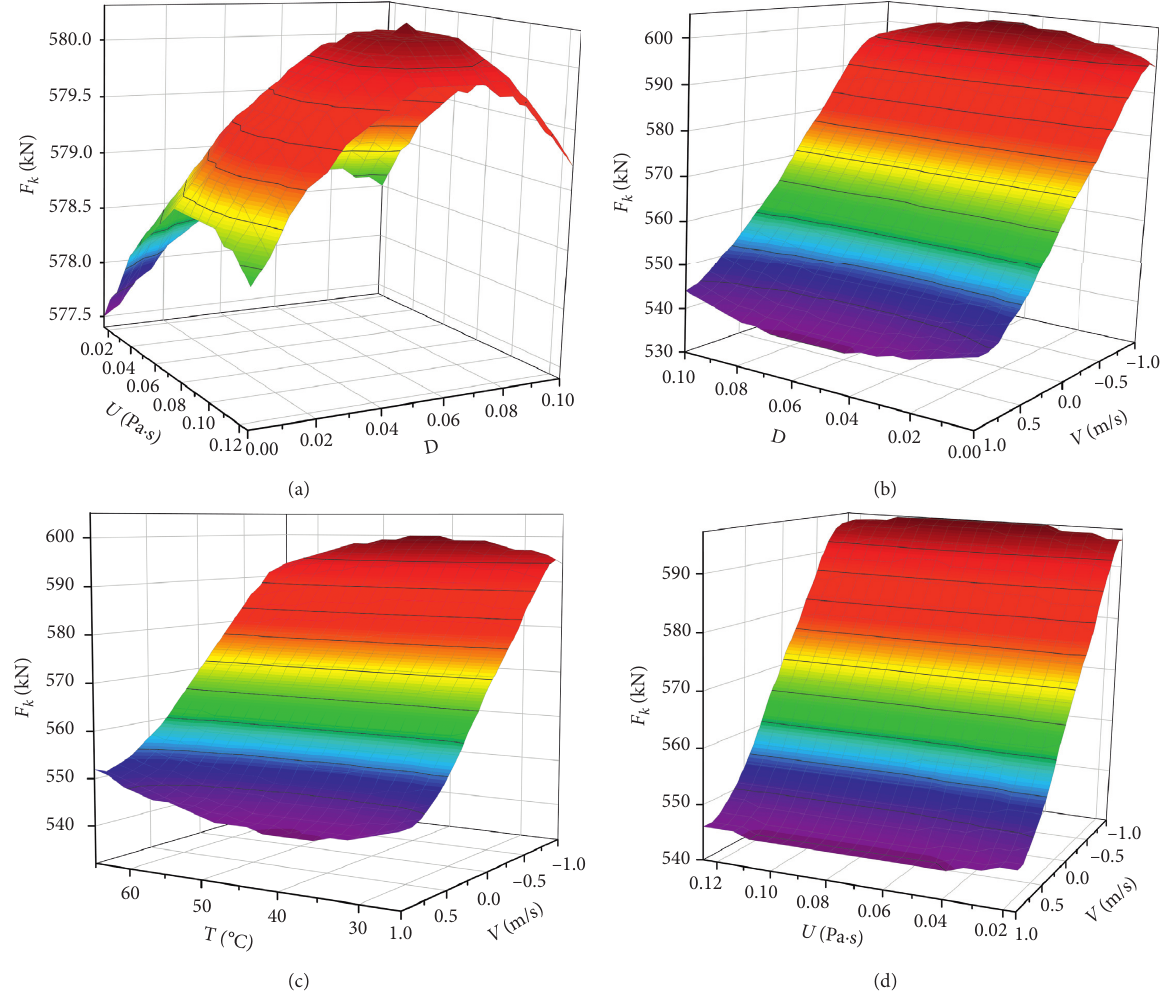
Figure 15: Surrogate models of the relationship between (a) stiffness force, gas dissolution rate, and oil viscosity; (b) stiffness force, suspension vibration speed, and dissolution rate; (c) stiffness force, suspension vibration speed, and temperature; and (d) stiffness force, suspension vibration speed, and oil